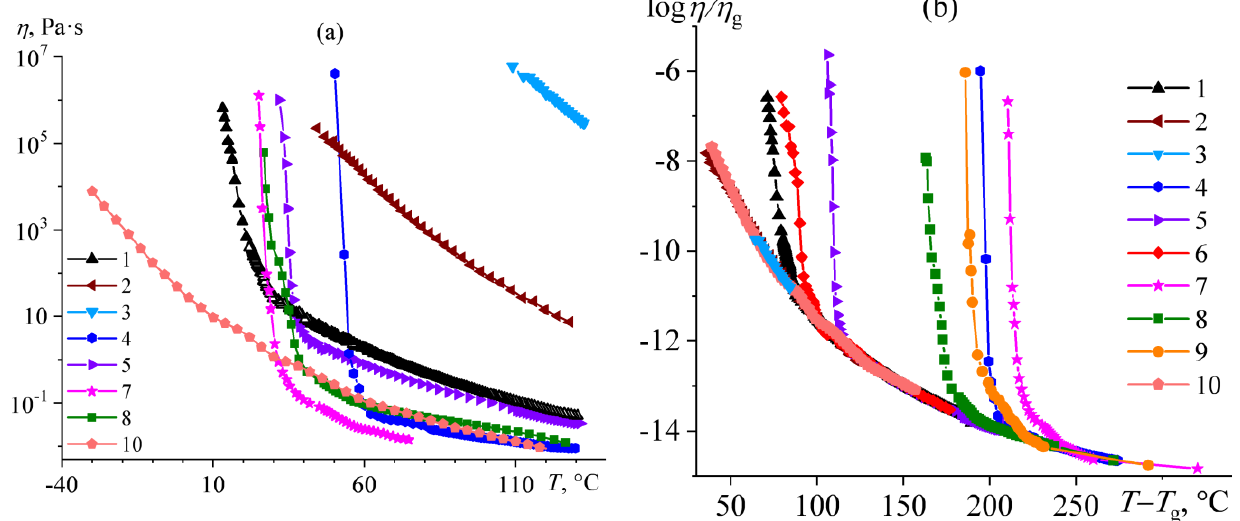
Figure 12. Typical temperature dependences of effective viscosity for bitumens ( a ) and the same dependences in the coordinates of the Williams – Landel – Ferry equation ( b ).